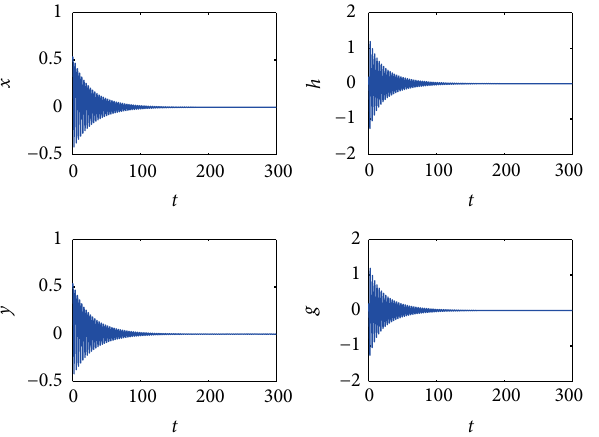
Figure 6: Simulated solution of Equation (2) for 𝑃 = 1000, 𝑟 = 4/3, 𝑐 = 94,𝜏 = 0.001 : the equilibrium (0 0 0 0) is asymptotically